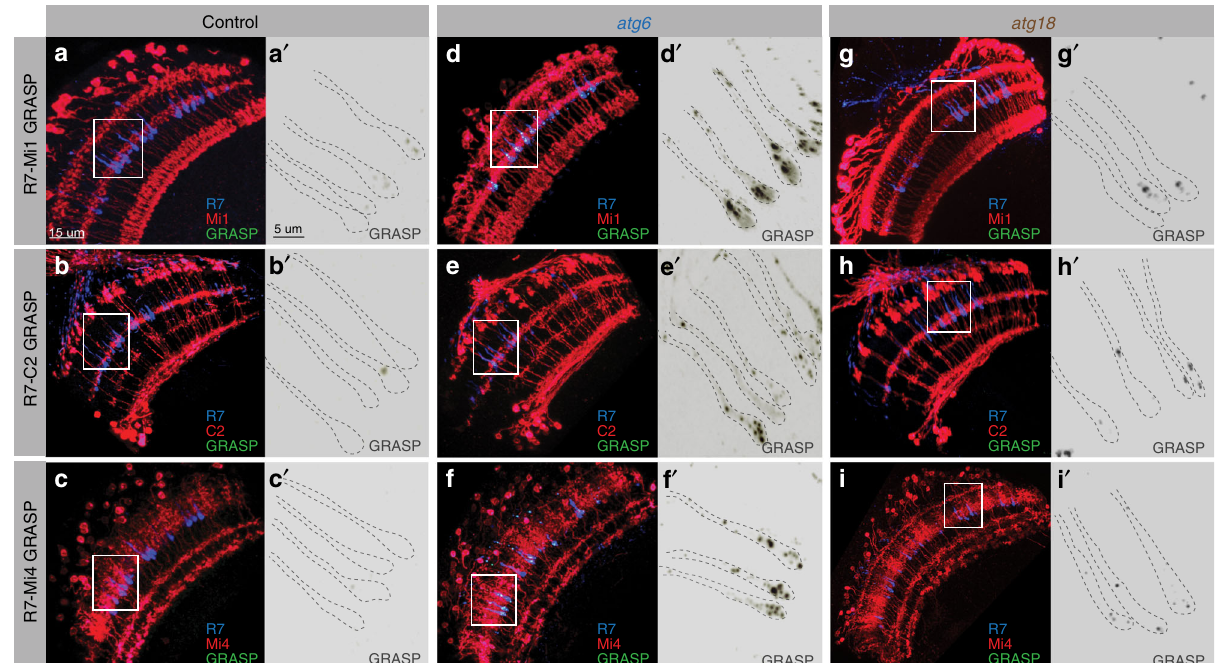
Fig. 4 Synaptic connections between autophagy-de fi cient R7s and aberrant postsynaptic partners are functional based on activity-dependent GRASP. a – c ’ Activity-dependent GRASP between control R7s and Mi1s ( a , a ’ ), C2s ( b , b ’ ), and Mi4s ( c , c ’ ) show that wild-type R7s very rarely form synaptic connections, if any, with Mi1, C2, and Mi4 neurons. d – f ’ Activity-dependent GRASP between atg6 mutant R7s and Mi1s ( d , d ’ ), C2s ( e , e ’ ), and Mi4s ( f , f ’ ) show widespread active synaptic connections between autophagy-de fi cient R7s and aberrant postsynaptic partners. g , i ’ , Activity-dependent GRASP between atg18 mutant R7s and Mi1s ( g , g ’ ), C2s ( h , h ’ ), and Mi4s ( i , i ’ ) show less frequent active synaptic connections compared with atg6 mutants. Note that Atg18 loss-of-function does not block autophagosome formation as effective as Atg6 loss-of-function (see Supplementary Fig. 1). Regions inside yellow rectangles are shown in close-up images as single greyscale GRASP channels. See Methods for Mi1, Mi4, and C2-speci fi c LexA drivers and detailed Drosophila genotypes used to perform GRASP experiments. Repeated three times independently with similar